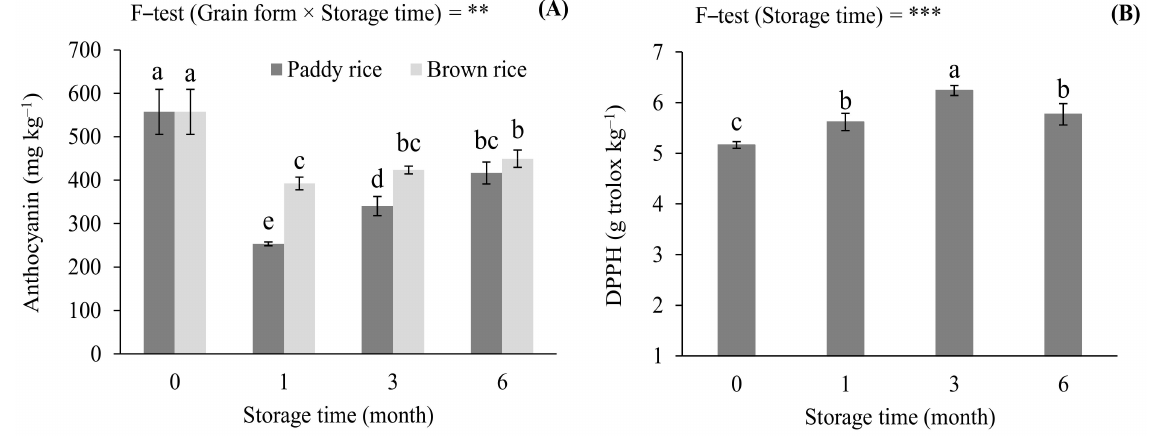
Figure 2. Anthocyanin concentration of the high-anthocyanin PES variety stored in paddy rice and brown rice forms for six months ( A ) and the DPPH activity of the high-antioxidant capacity KAK variety stored for six months ( B ). Data were analyzed by F-tests (** p < 0.01, *** p < 0.001). Different letters indicate least significant differences ( p < 0.05). The values of anthocyanin concentration and DPPH activity are expressed as mean ± SD ( n =